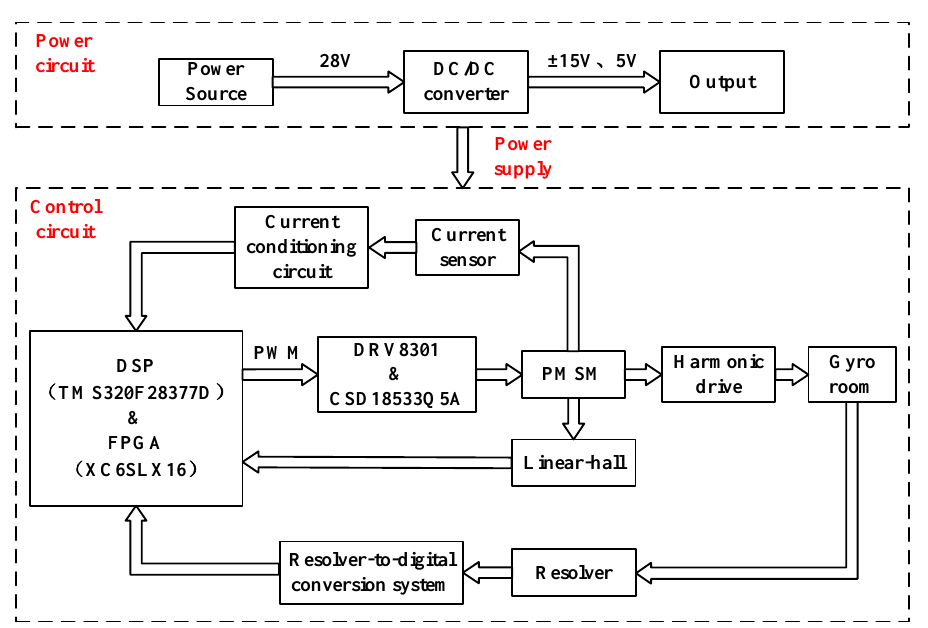
Figure 9. SGCMG prototype.